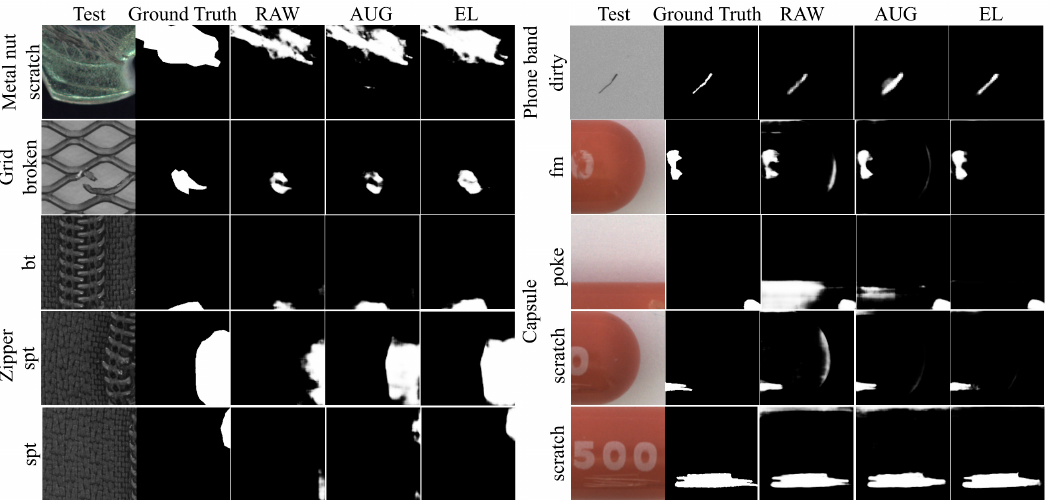
Figure 10. Comparison of UNet-based segmentation results. Test and Ground Truth denote the test images and the corresponding ground truth (256 2 ). RAW , AUG , and EL denote the test results obtained by the three training sets (256 2 ).